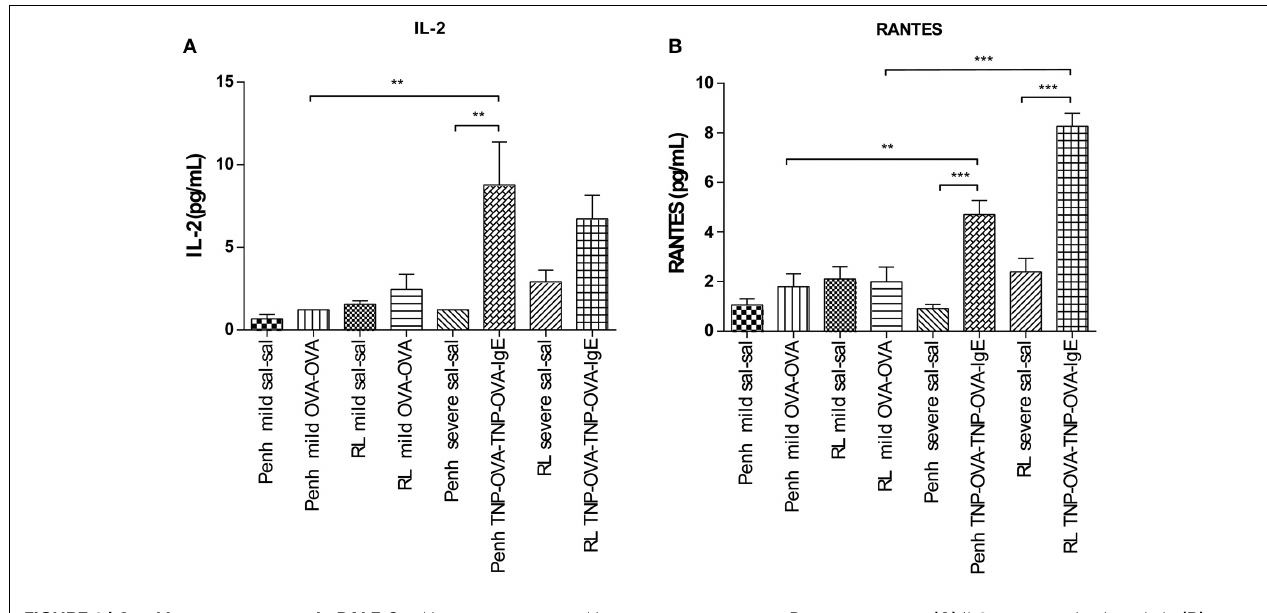
measurement or R L measurement. (A) IL-2 concentration in pg/mL, (B) RANTES concentration in pg/mL. Values are expressed as mean ± s.e.m. ∗∗ P < 0 . 01, ∗∗∗ P < 0 . 001 using a One-Way ANOVA followed by a Bonferroni test, n = 4–5